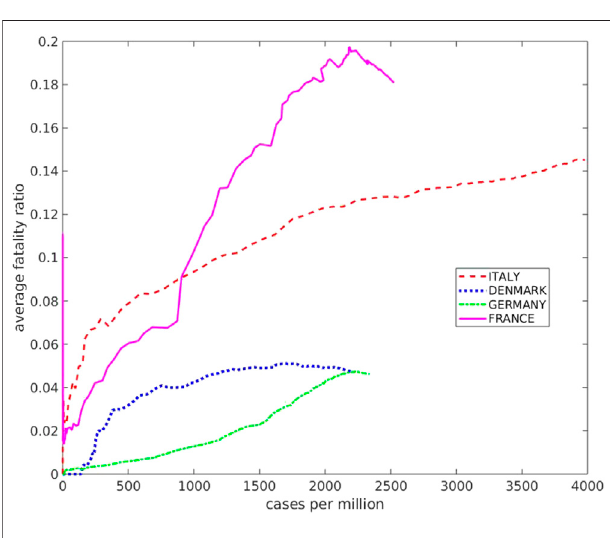
FIGURE 6 | The average fatality ratio as a function of the cumulative number of infected per million inhabitants for the countries discussed here.